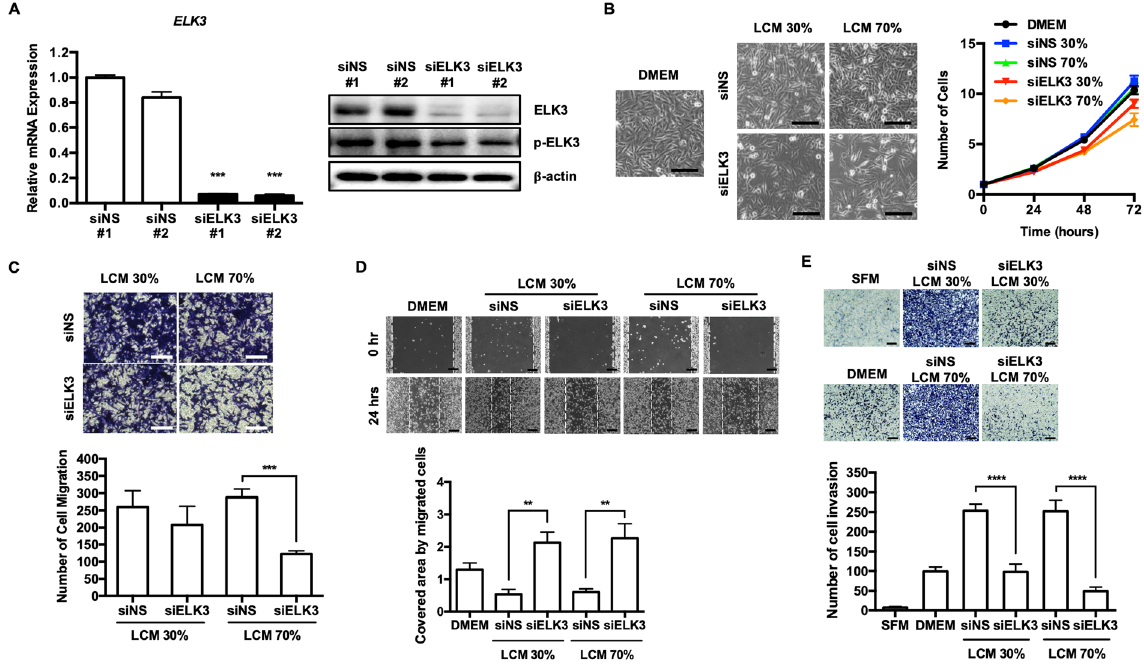
Figure 2. The role of LCM in supporting the migration and invasion of breast cancer cells in vitro was associated with the expression level of ELK3 in LECs. ( A ) The suppression of ELK3 in LECs via the transfection of a siRNA targeting ELK3 was confirmed by qRT-PCR and immunoblot analysis. ( B ) MDA-MB-231 cell proliferation was assessed in DMEM, 30% siNS LCM, 30% siELK3, 70% siNS and 70% siELK3. MDA-MB-231 cell proliferation in 30% or 70% siELK3 LCM was significantly lower than that in DMEM, whereas the cell proliferation of MDA-MB-231 cells in 30% or 70% siNS LCM was slightly higher than that observed in DMEM. Scale bar represents 100 μ m. ( C ) The effect of siNS or siELK3 LCM on the migration of MDA-MB-231 cells was analyzed by a transwell assay. MDA-MB-231 cells educated in the indicated LCM were cultured in a transwell chamber for 24 h. The migrated cells were stained with crystal violet (Left) and quantified (Right). Scale bar represents 100 μ m. ( D ) A scratch wound healing assay was performed to examine the effect of siNS or siELK3 LCM on the migration of MDA-MB-231 cells (Left). The cells were cultured in the indicated LCM, and migration was observed 24 h after scratching (Left) and photographed (Right). Scale bar represents 200 μ m. ( E ) Matrigel invasion of MDA-MB-231 cells toward EGF in the presence of the indicated LCM. Scale bar represents 200 μ m. Error bars represent the standard error from three independent experiments, and each experiment was performed using triplicate samples. * P < 0.05, ** P < 0.01 *** P < 0.001 and **** P < 0.0001 (Student’s